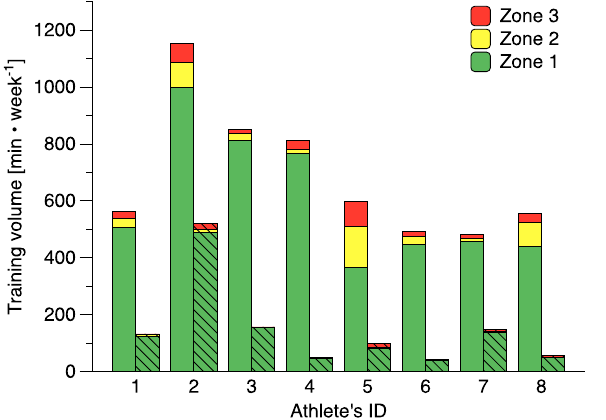
Figure 2. Training volume and intensity distribution during regular training (TRAIN, solid colors) and during all other waking hours (OFF, hatched) in eight national elite rowers. Zones refer to intensity zones, with zone 1 ranging from 60 ≤ 82% of maximum heart rate, zone 2 ranging 82 ≤ 88%, and zone 3 from 88 to 100% of maximum heart rate. The percentages of individual training intensity distributions (%Zone1–%Zone3–%Zone3) during TRAIN/OFF were #1: 90-6-4/95-4-2, #2: 87-8-6/95-2-4, #3: 96-3-2/99-0-0, #4: 94-2-4/95-2-3, #5: 61-24- 15/84-5-12, #6: 91-6-4/94-5-1, #7: 95-2-3/94-2-4, and #8: